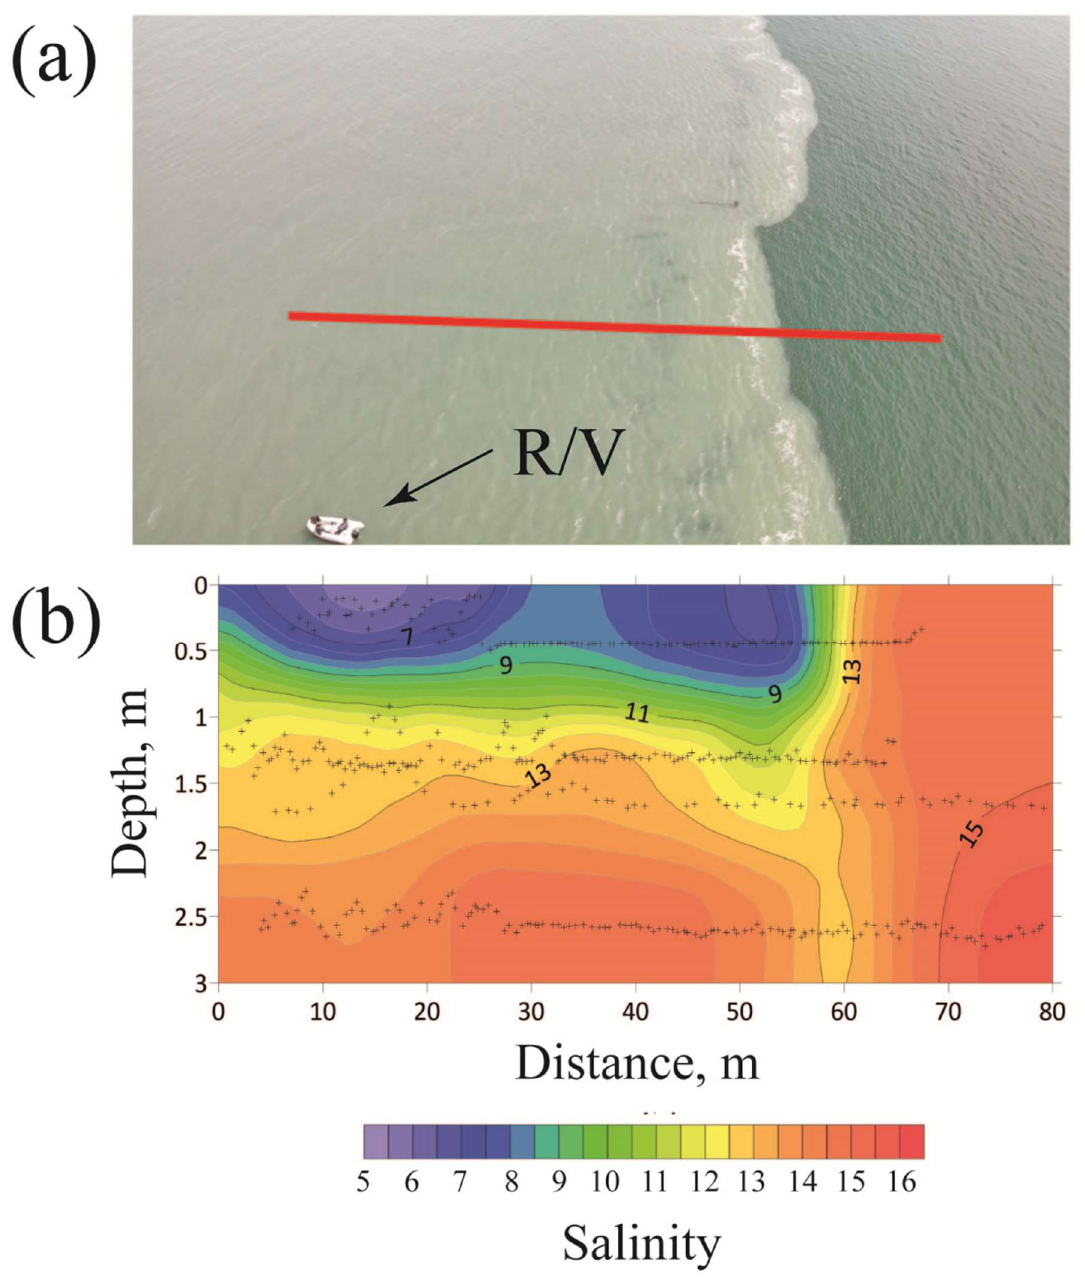
Figure 5. Stripe of reduced salinity and turbidity formed along the far-filed part of the plume border visible at: ( a ) aerial image of the Bzyb plume border and ( b ) salinity structure across the Bzyb plume border on 15 April 2021. Red line in panel ( a ) indicates location of the cross-border transect. Black crosses in panel ( b ) indicate points of in situ measurements.